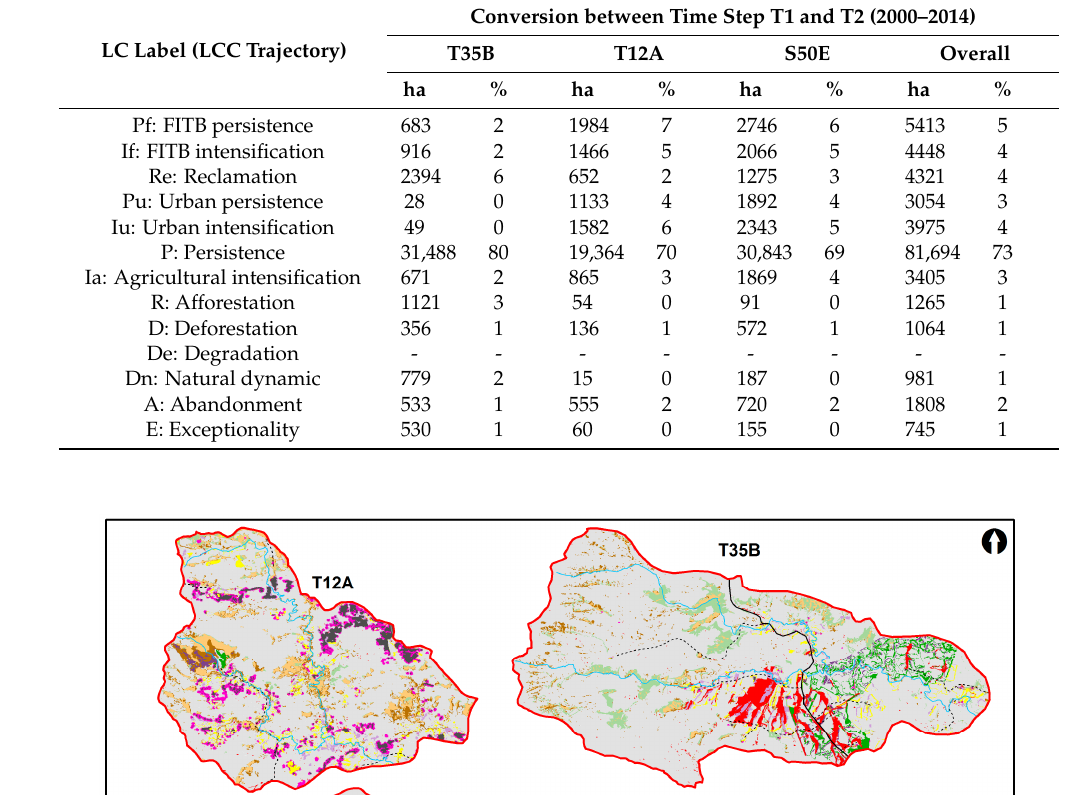
Table 10. LC conversion (area and percentage) described using LC labels.